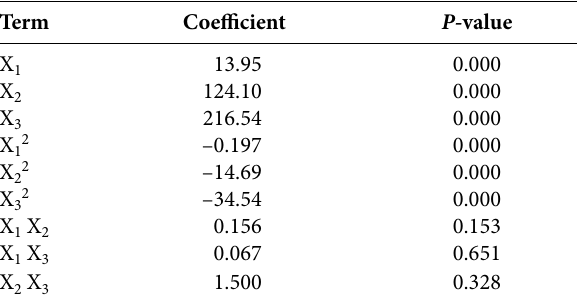
Table 2. All estimated regression coefficients for response